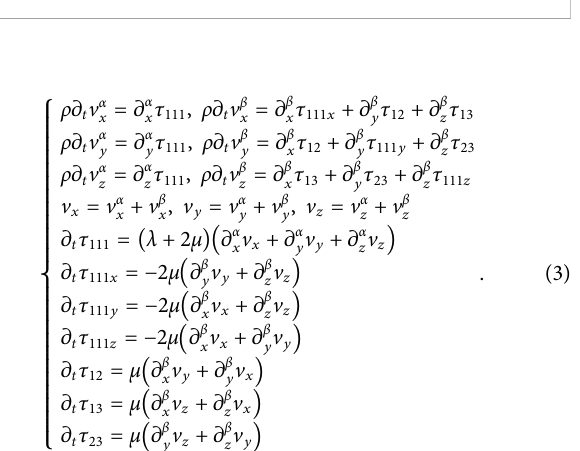
FIGURE 1 Staggered-grid fi nite-difference (SGFD) stencil of the fourth-order temporal accuracy and arbitrary even-order spatial accuracy, r , ϕ , φ ∈ ( x , y , z ) and r ≠ ϕ ≠ φ